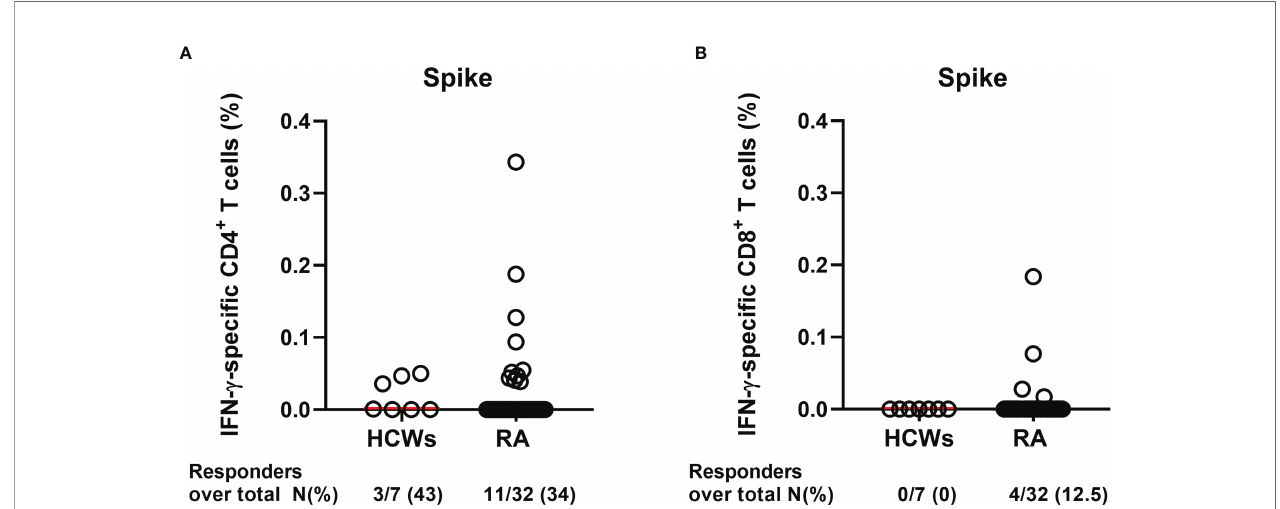
FIGURE 8 | Evaluation of IFN- g -S-speci fi c T-cell response by fl ow cytometry. Cells from whole blood from HCWs (n = 7) and RA patients (n = 32) were stimulated for 24 h with spike peptide pool, and the percentage of IFN- g -speci fi c T cells was assessed by fl ow cytometry. Graphs show the frequency of the (A) CD4 + and (B) CD8 + IFN- g -speci fi c T-cell response (after subtraction of the unstimulated sample) in HCWs and RA patients. Each dot is a different HCW or RA individual, and red lines indicate the median. Mann – Whitney U-test was performed for the statistical analysis, and the p-value ≤ 0.05 was considered signi fi cant. RA, rheumatoid arthritis; HCWs, health care